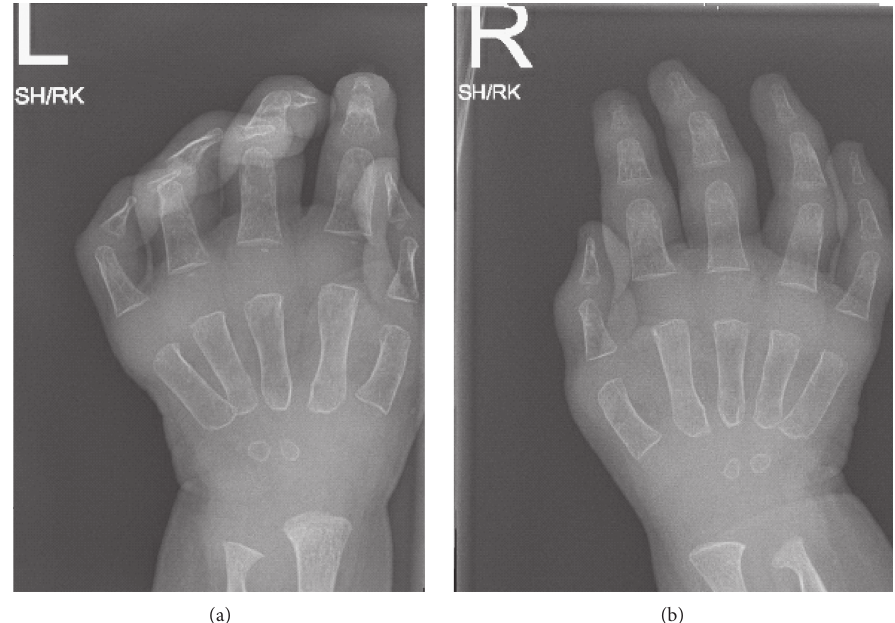
Figure 2: X-ray of the patient’s hands (left: labelled L and right: labelled R) showing soft tissue swelling of both distal hands with grossly maintained joint spaces.